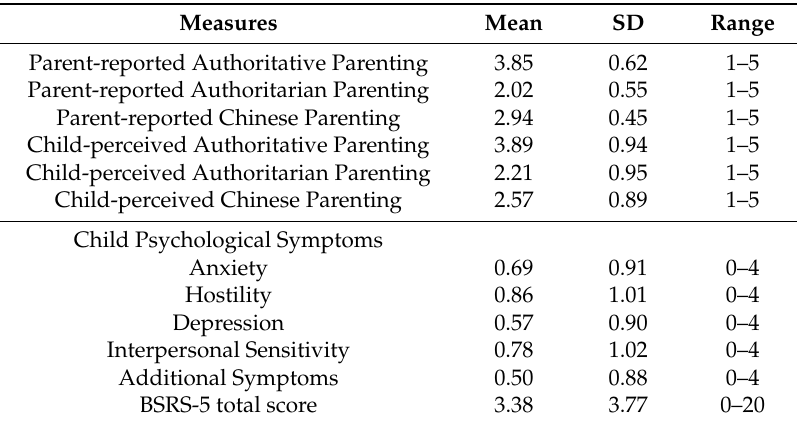
Table 2. Mean, standard deviations, and range of variables.